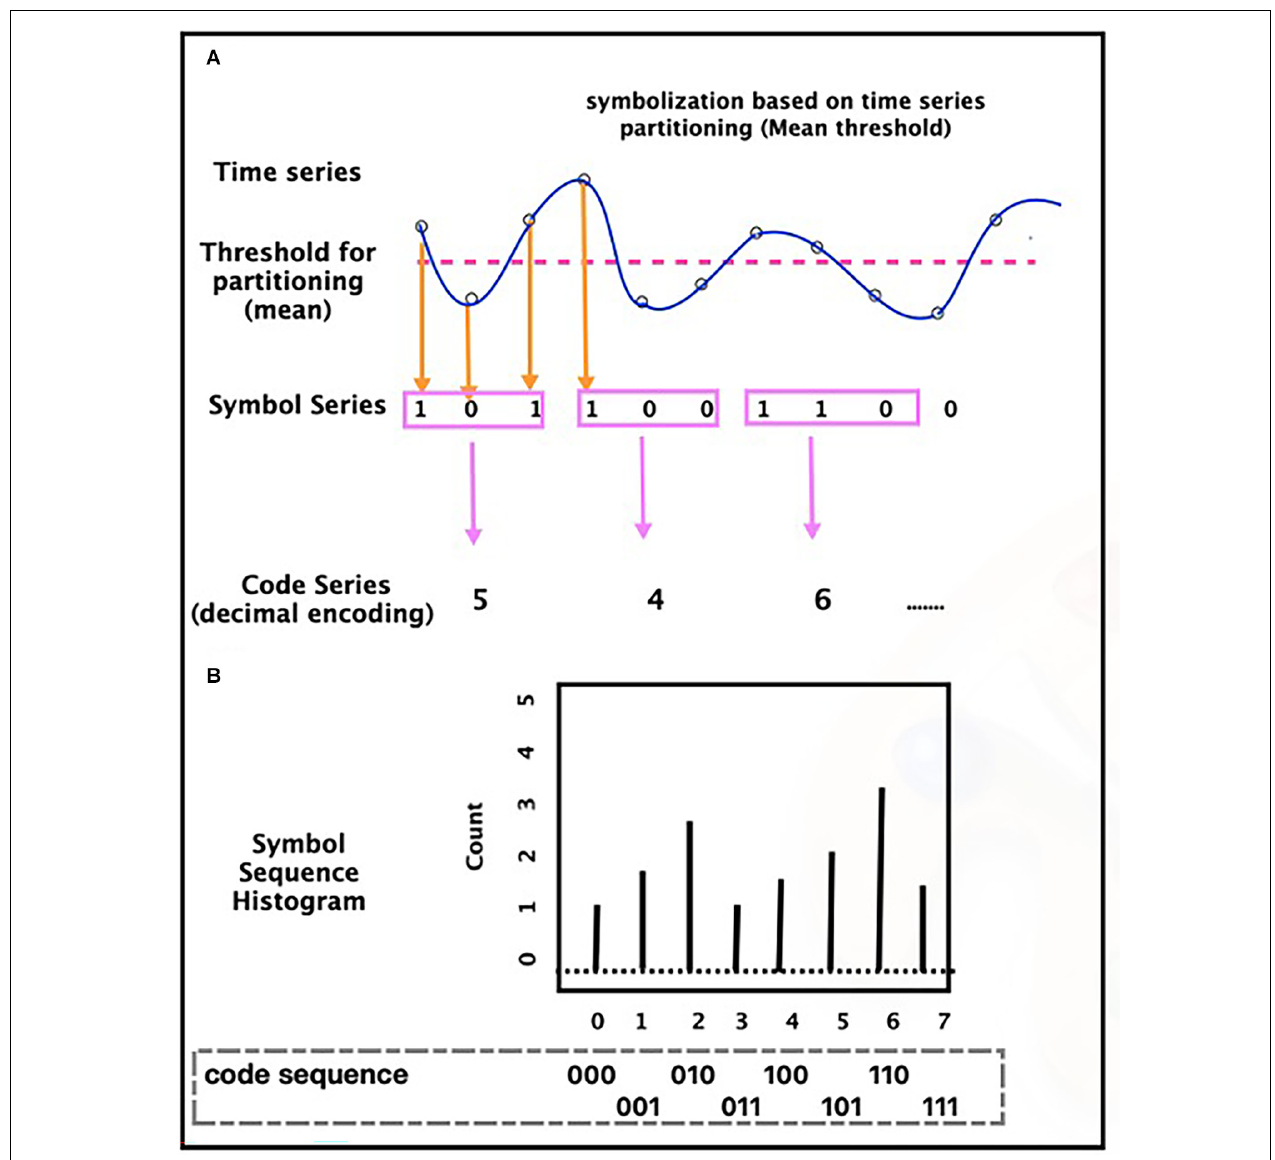
FIGURE 2 | Time series symbolization process (A) and tabulating a histogram of symbol sequence (B) —based on a threshold (for example, mean , in this figure), the time-series convert to a symbol sequence (series). Based on the length considered for the words, the sequence of symbols becomes a series of words. Then, the analysis of the words is usually performed by statistical analysis of the words occurrence, frequency, like